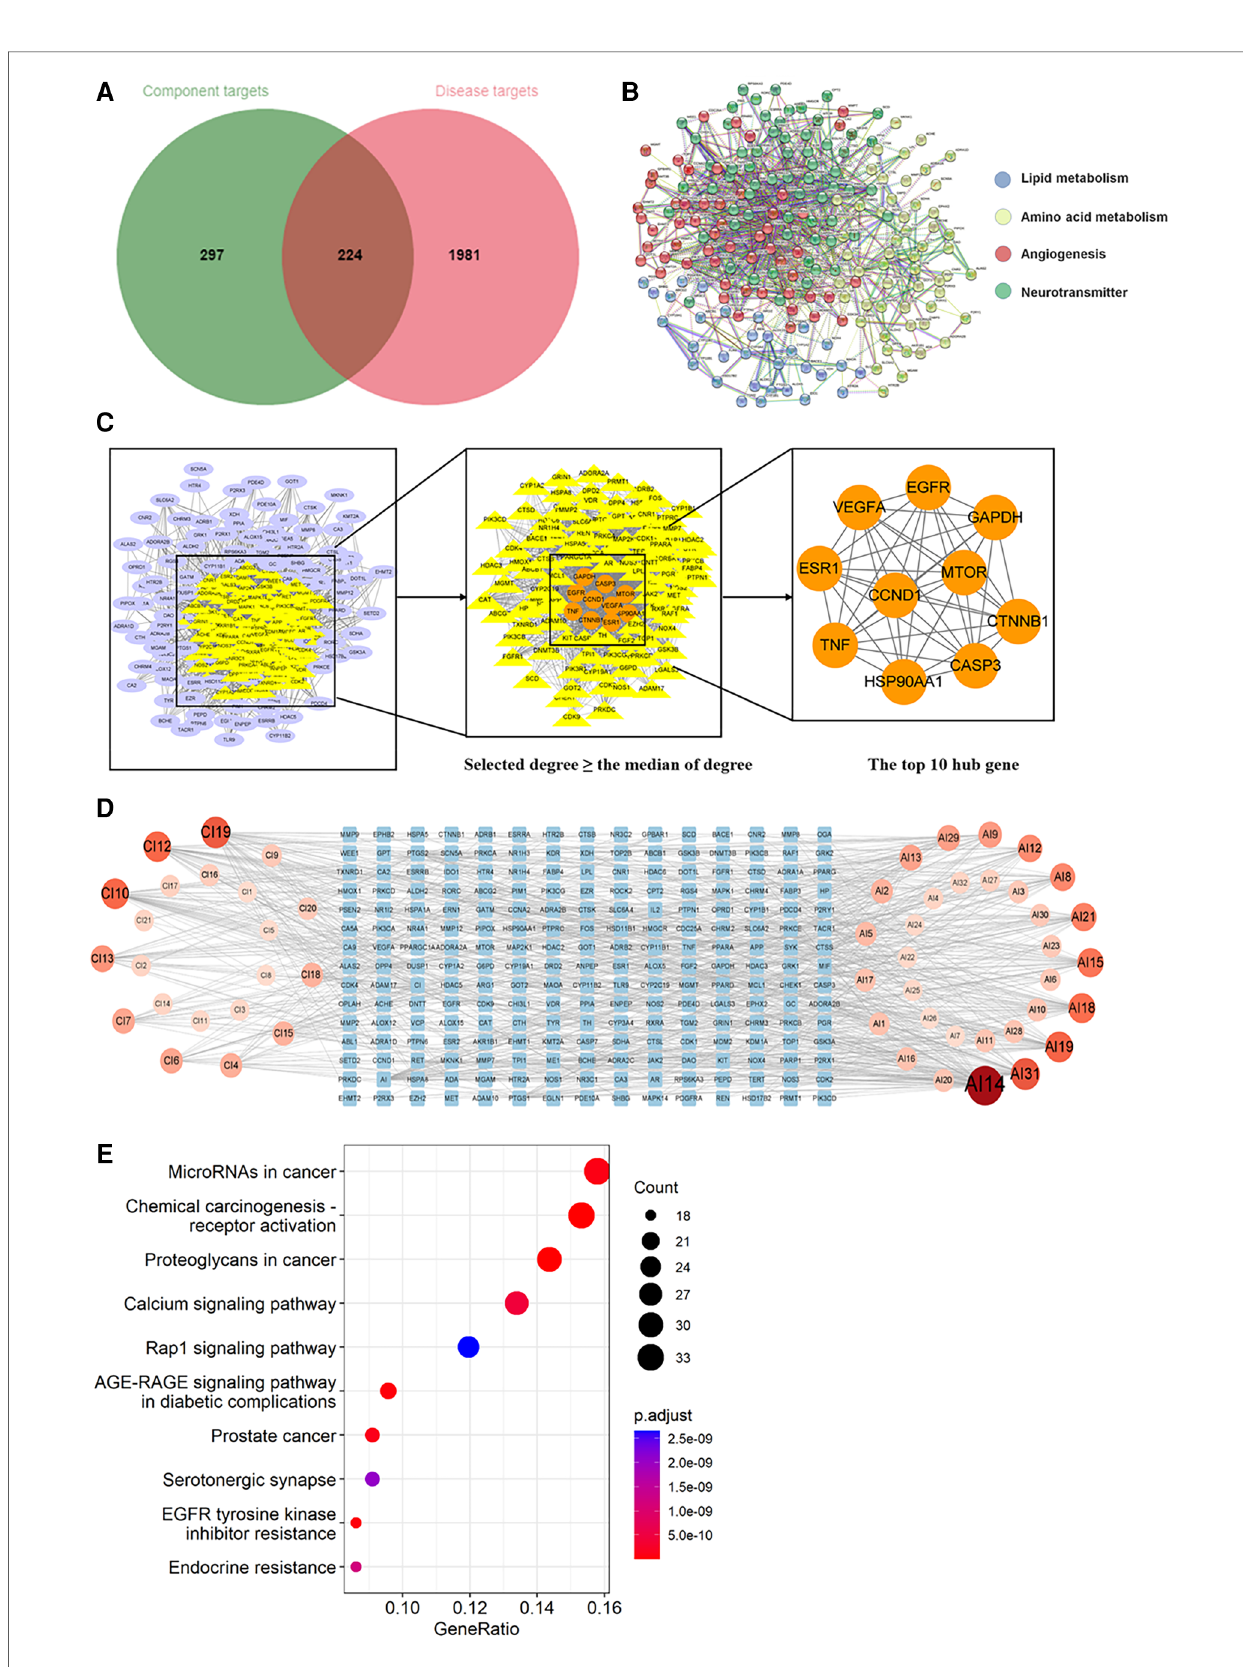
FIGURE 10 Analysis of target genes about Astragalus with cinobufotalin injection. ( A ) Venn diagram of component target genes and disease target genes. The green circle stands for effective component target genes. The red circle stands for AIC target genes, and the intersection genes are shown in the middle. ( B ) The PPI network of the intersection genes. ( C ) Network topology analysis to screen the hub targets. ( D ) Component-Target Network of the active components and the target genes. ( E ) KEGG enrichment analysis of hub